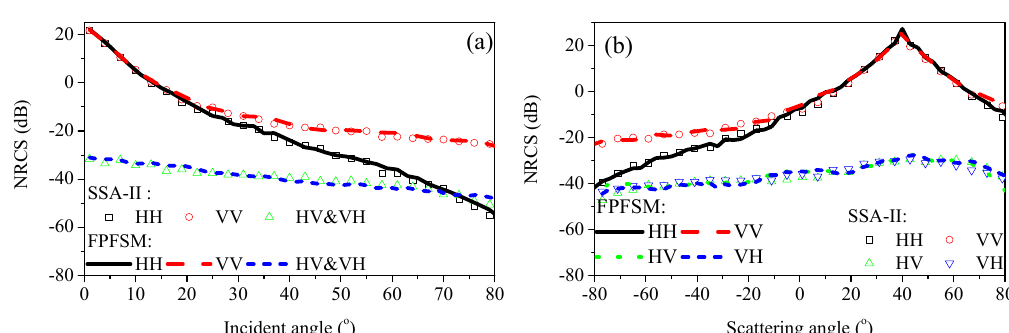
Figure 5. Comparison of the NRCS results calculated by FPFSM and SSA-II at ultra high frequency (UHF) band. ( a ) Monostatic configuration; ( b ) Forward–backward configuration.